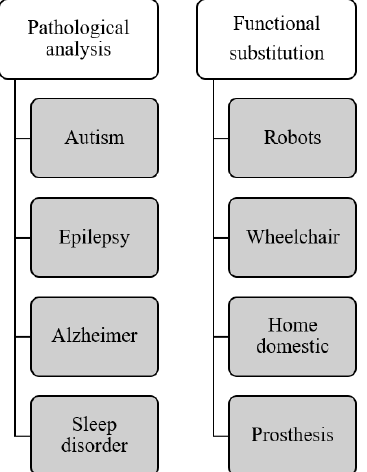
Figure 1. The main application domain of